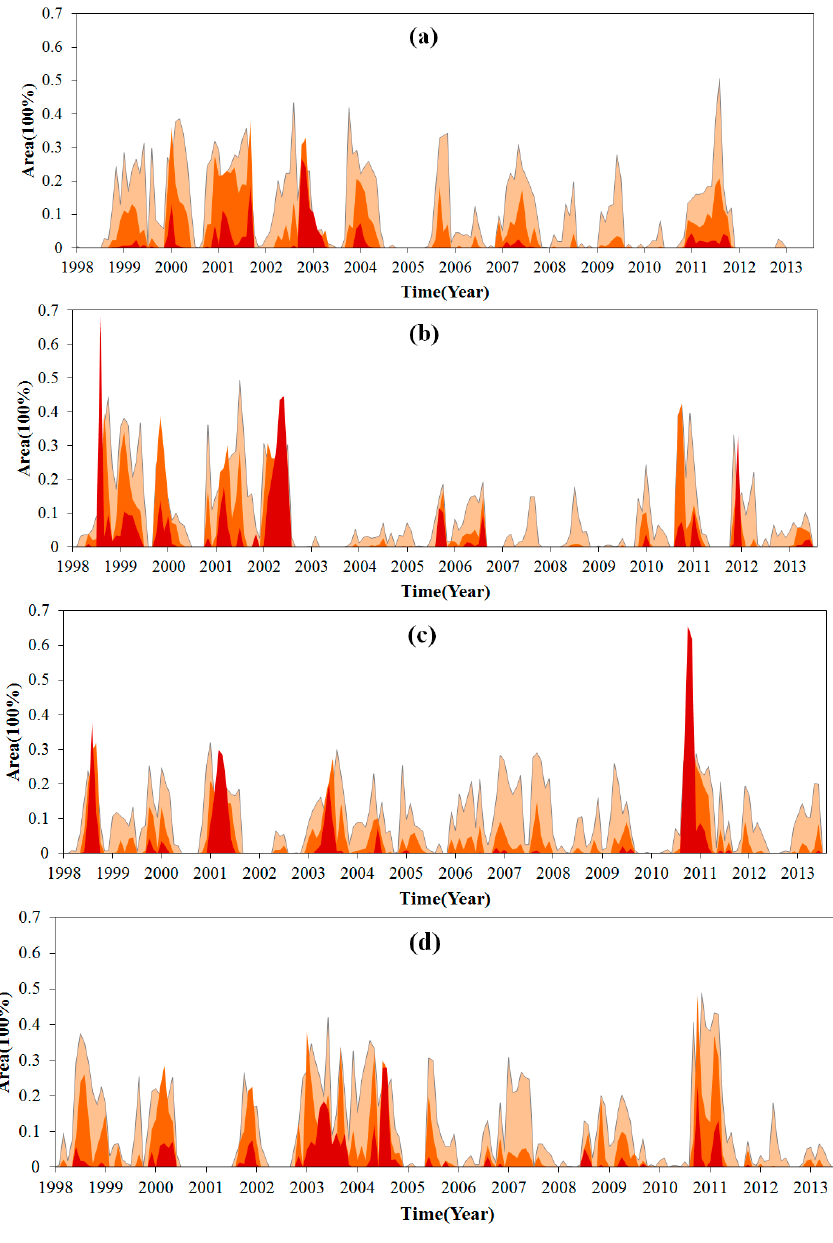
Figure 5. Frequencies of moderate droughts, severe droughts and extreme droughts for different regions from 1998 to